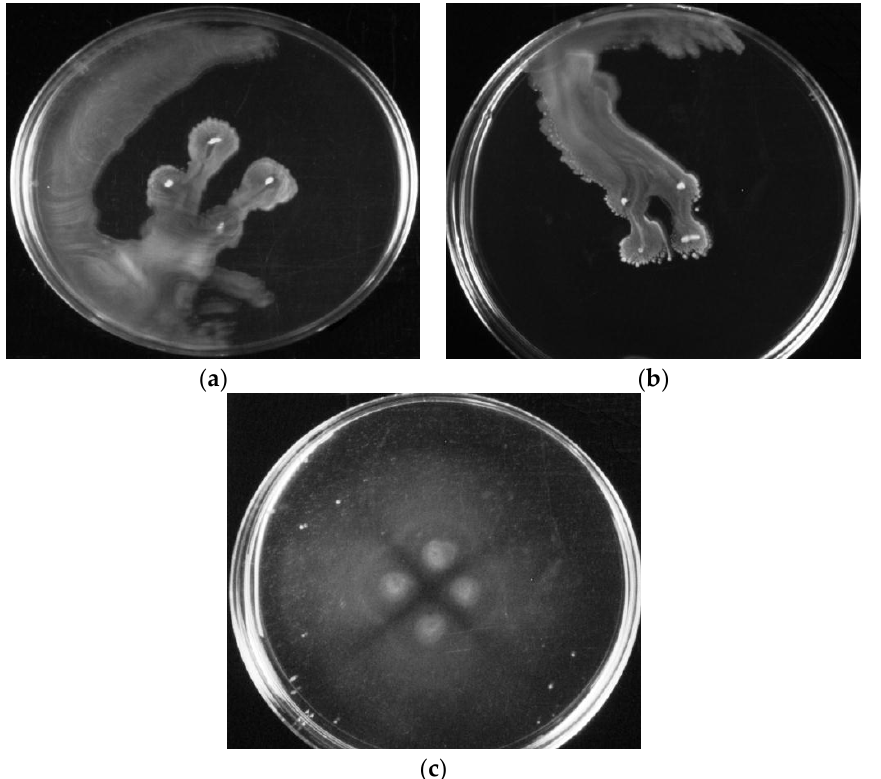
Figure 5. Motility of Methylobacterium in different substrate conditions at 0.2% agar medium after 12 h of incubation at 28 °C: ( a ) in 3 g/L R2A; ( b ) in 3 mg/L R2A; ( c ) in drinking water.